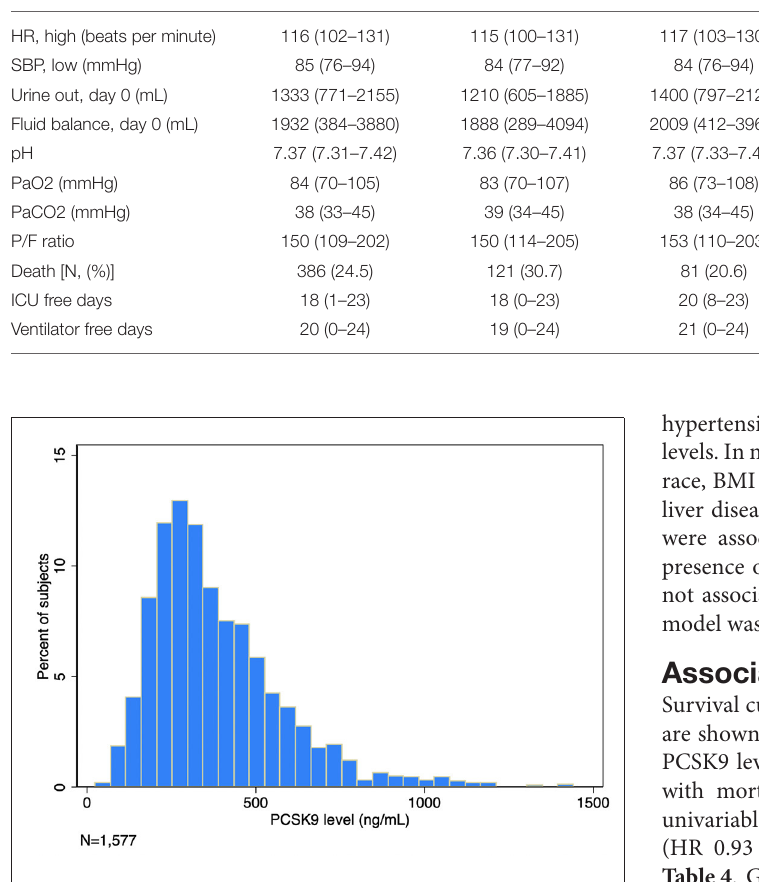
FIGURE 1 | Circulating plasma PCSK9 in 1,577 subjects with